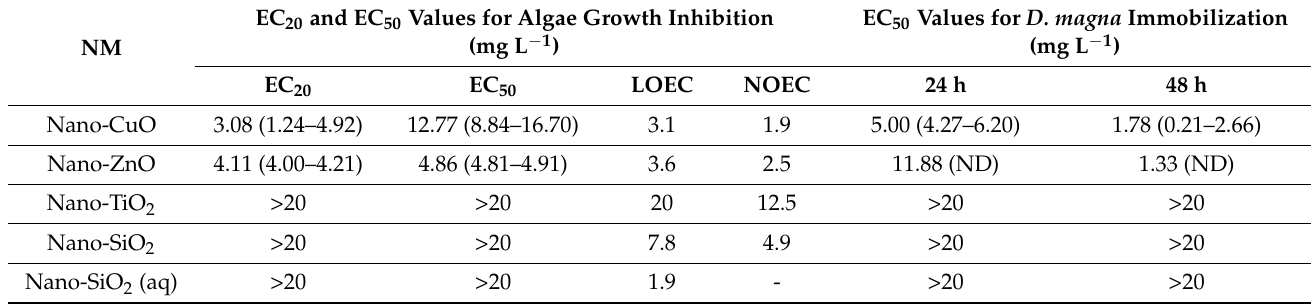
Table 2. Effective concentrations (EC 20 and EC 50 values), LOEC and NOEC of NM obtained for microalgae growth inhibition and (EC 50 ) for D. magna immobilization after 24 and 48 h of